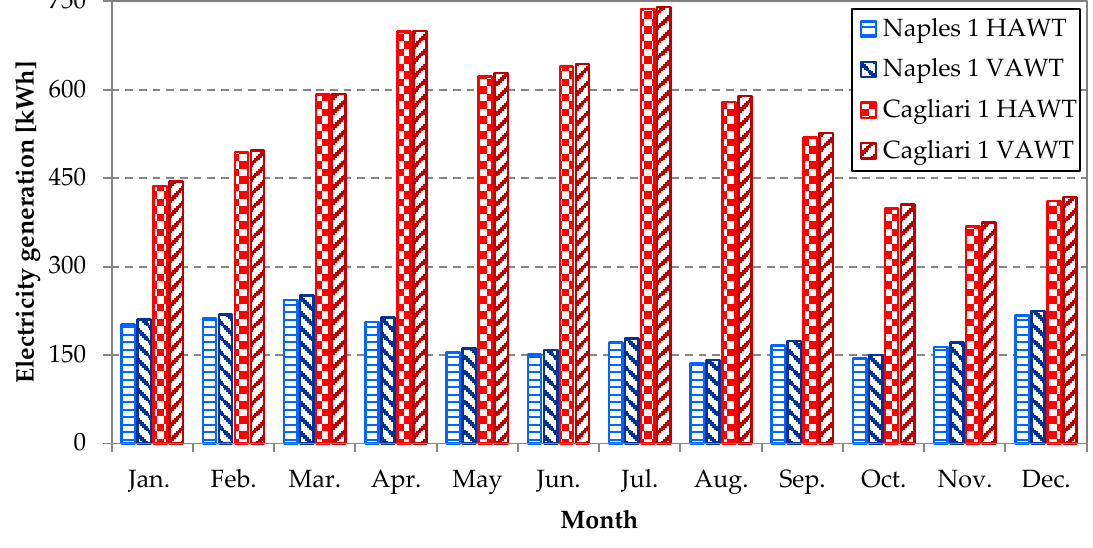
Figure 8. Horizontal and vertical axis wind turbine (HAWT and VAWT) electricity generation on a monthly basis for both Naples and Cagliari.